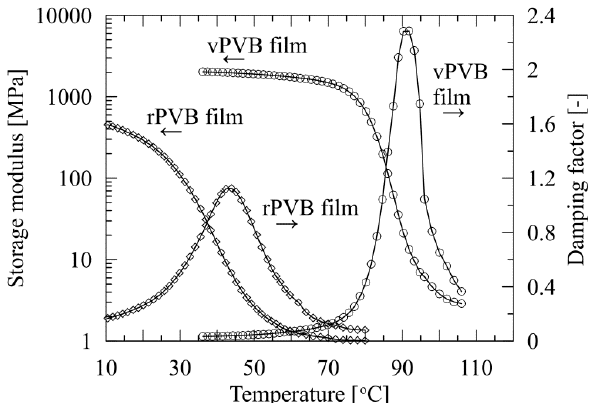
Figure 13. Comparison of temperature dependent behavior of storage modulus and damping factor (tan delta) of rPVB and vPVB films.